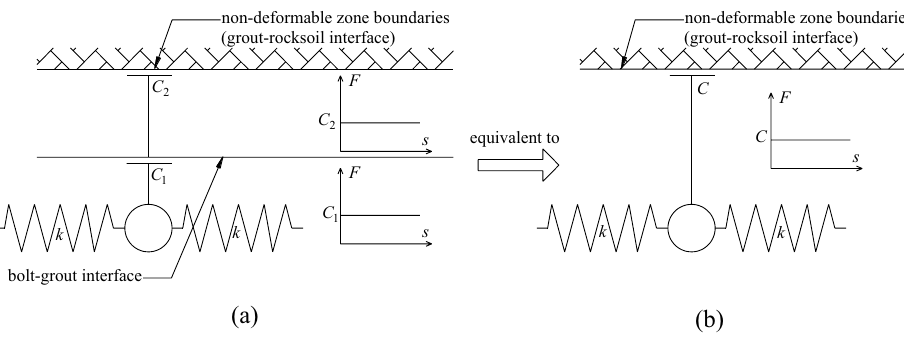
Figure 6. Evolution of the slider model. ( a ) When both interfaces are friction; ( b ) The slider